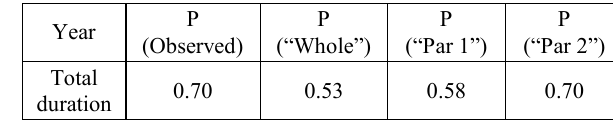
Fig. 4. Comparison between model results and observed concentrations, yearly averaged values (phosphorus). Table 4. Phosphorus results from model simulation, considering only punctual pressures (total simulation duration average).